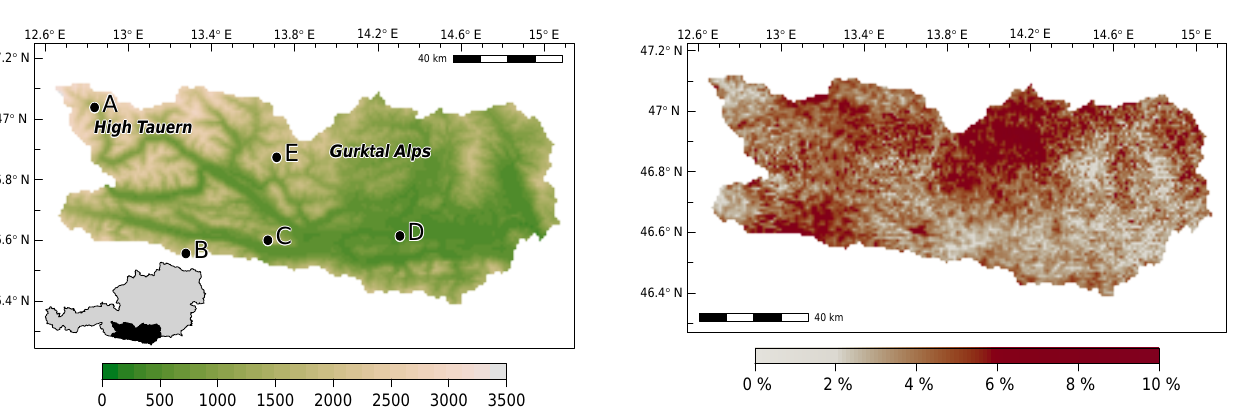
Figure 1. Altitude of Carinthia (ma.m.s.l.) averaged over 1km × 1km cells. Attributes of sample locations are listed in Ta- ble 1. The location map shows the location of Carinthia (black) in Austria (light grey).